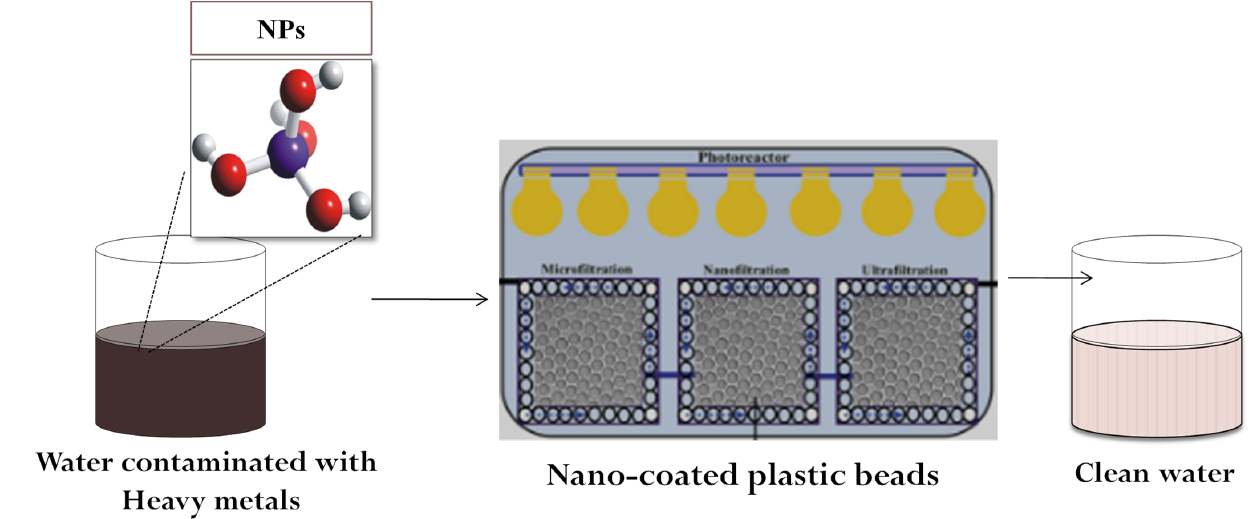
Figure 2. Nanoparticle-mediated water remediation.